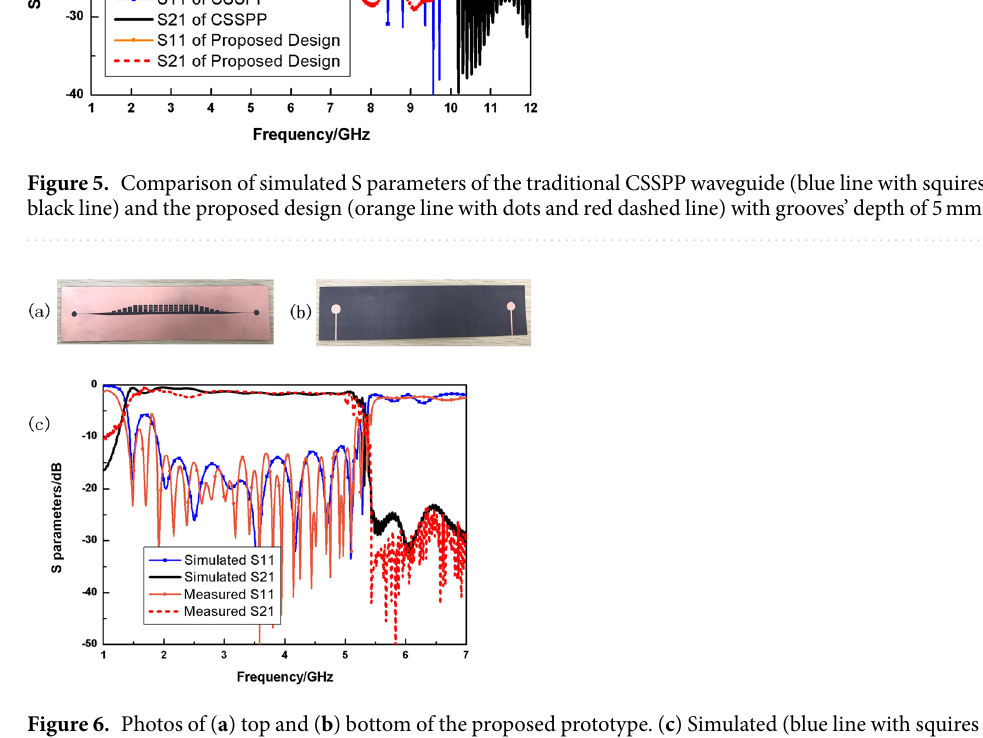
Figure 6. Photos of ( a ) top and ( b ) bottom of the proposed prototype. ( c ) Simulated (blue line with squires and black line) and measured (orange line with dots and red dashed line) S parameters of the proposed